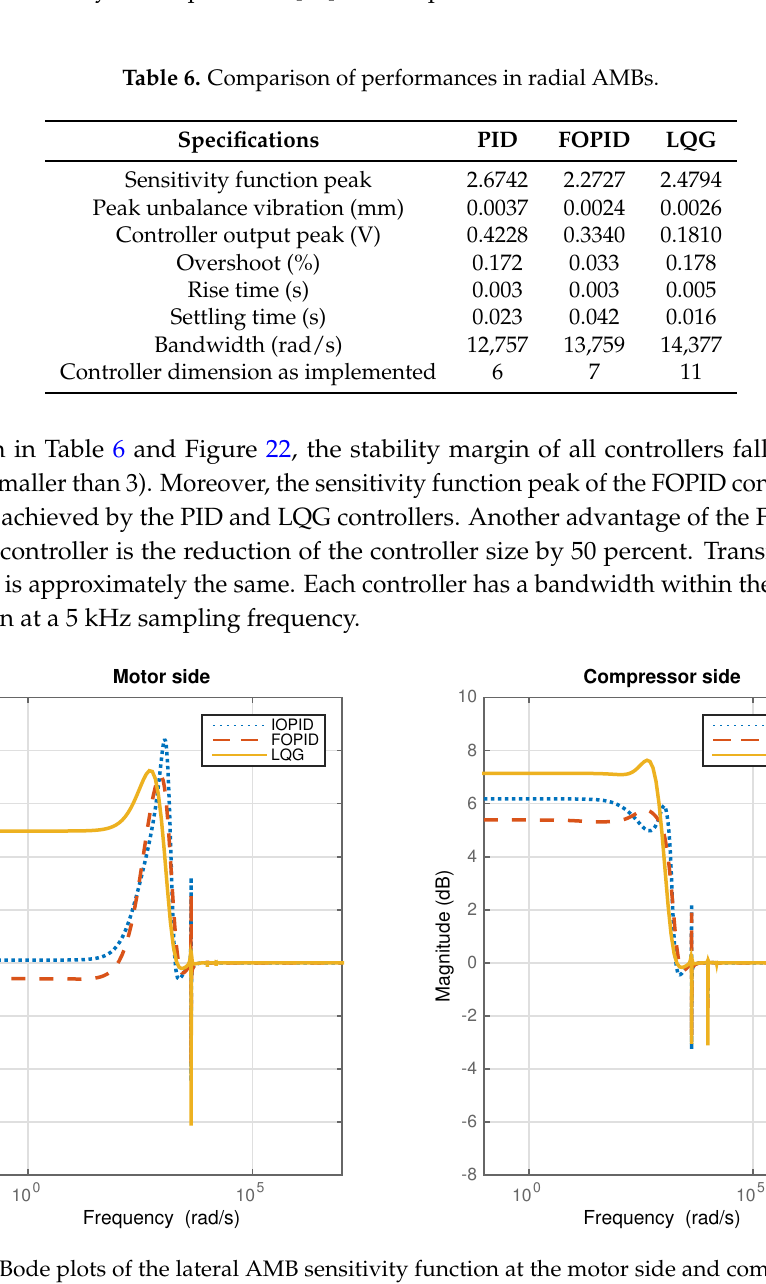
Figure 22. Bode plots of the lateral AMB sensitivity function at the motor side and compressor side under three different